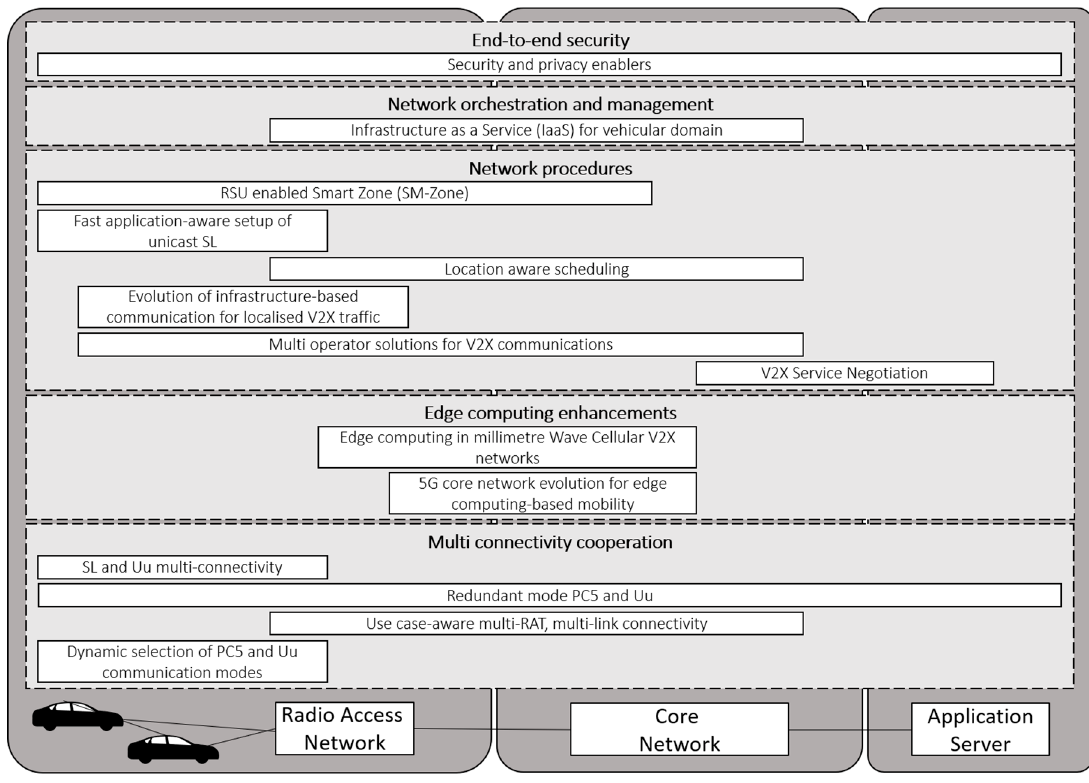
Figure 3. The 5G Communication Automotive Research and innovation (5GCAR) enhancements for the end-to-end system architecture, highlighting the areas the different enhancements refer to.